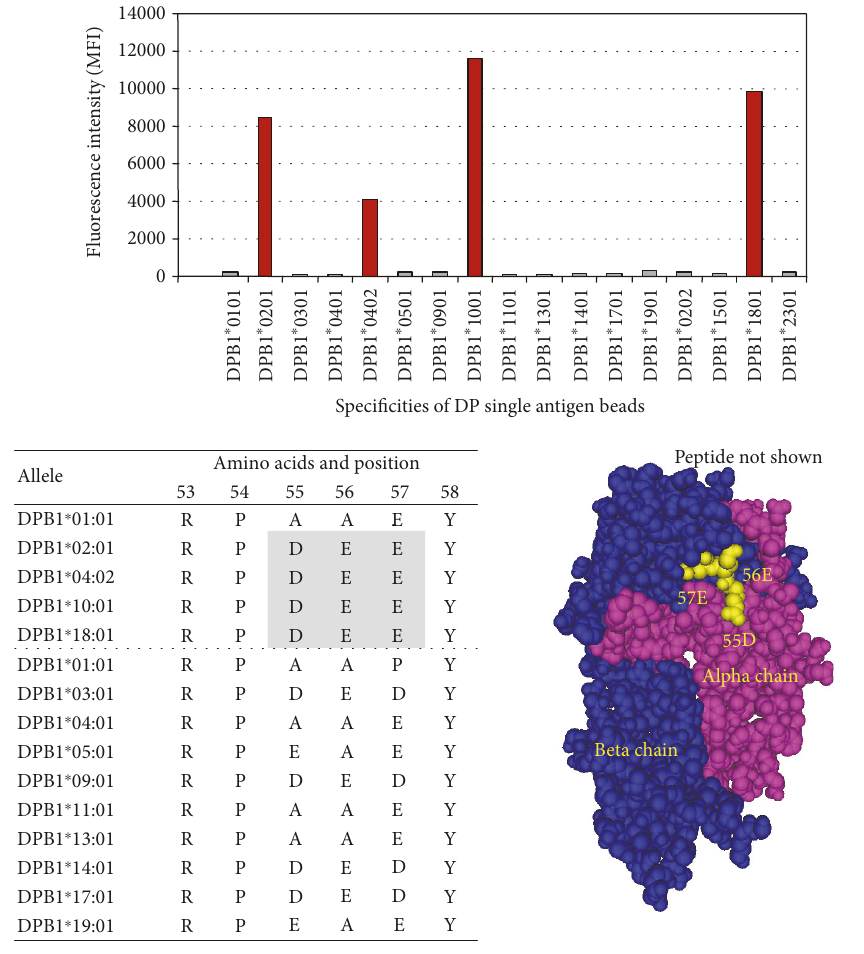
Figure 15: HLA class II DP epitope 4003 shared by DPB chains DPB1 ∗ 0201 , DPB1 ∗ 0402 , DPB1 ∗ 1001 , and DPB1 ∗ 1801 (red bars) and de fi ned by 84D+ 85E+ 86A+ 87V. Negative antigens that did not share epitope 4003 are shown in (gray